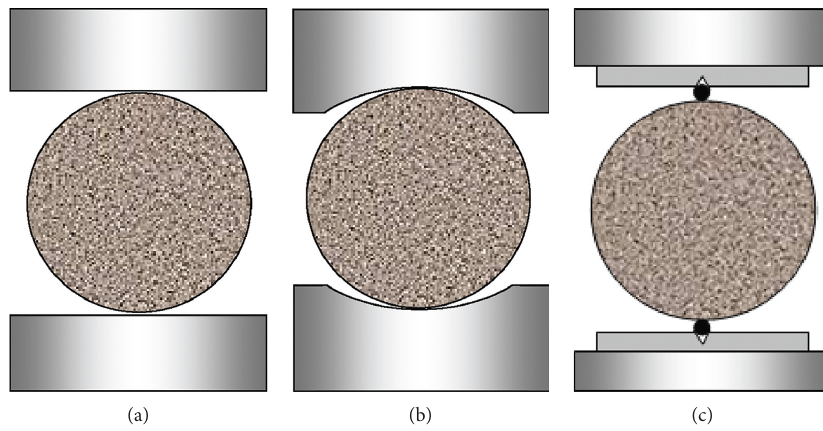
Figure 3: Three typical Brazilian disc test loading methods. (a) Plate loading. (b) Circular arc loading. (c) Strip loading.